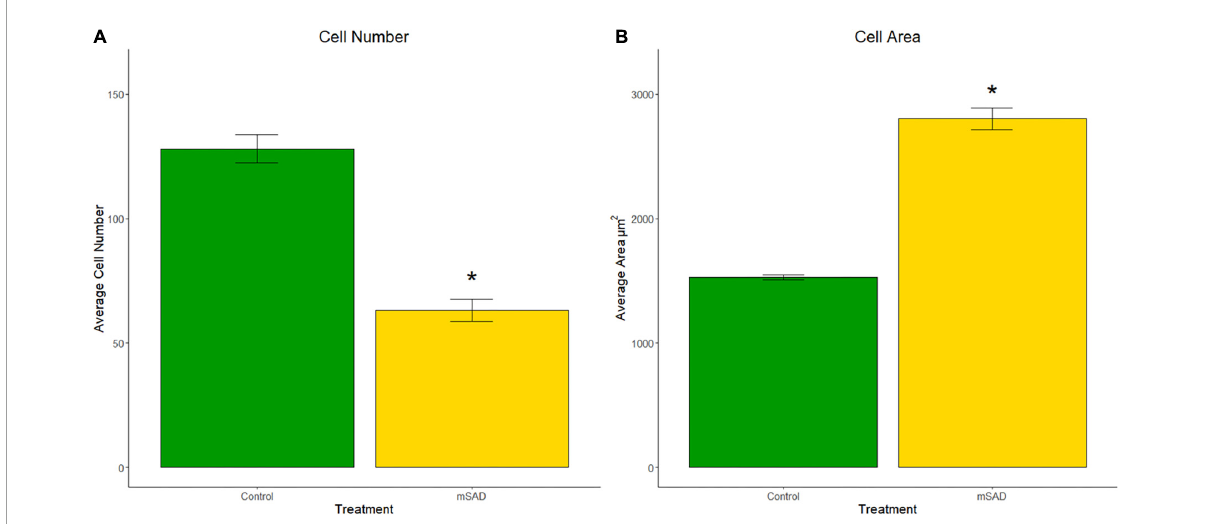
FIGURE5 Effects of diet on gonadal adipocyte hyperplasia and hypertrophy. Cell counts and cell area measurements were performed on FFPE sections of gonadal fat pads stained with hematoxylin. Cell counts (A) and cell area measurements (B) were quantified. Values are representative of average cell count and average cell area ( µ m 2 ) of multiple regions of interest (CON, n = 6; mSAD, n = 3) each measuring 500 µ m × 500 µ m. Data were compared using the unpaired Wilcoxon rank-sum test. * p < 0.001.